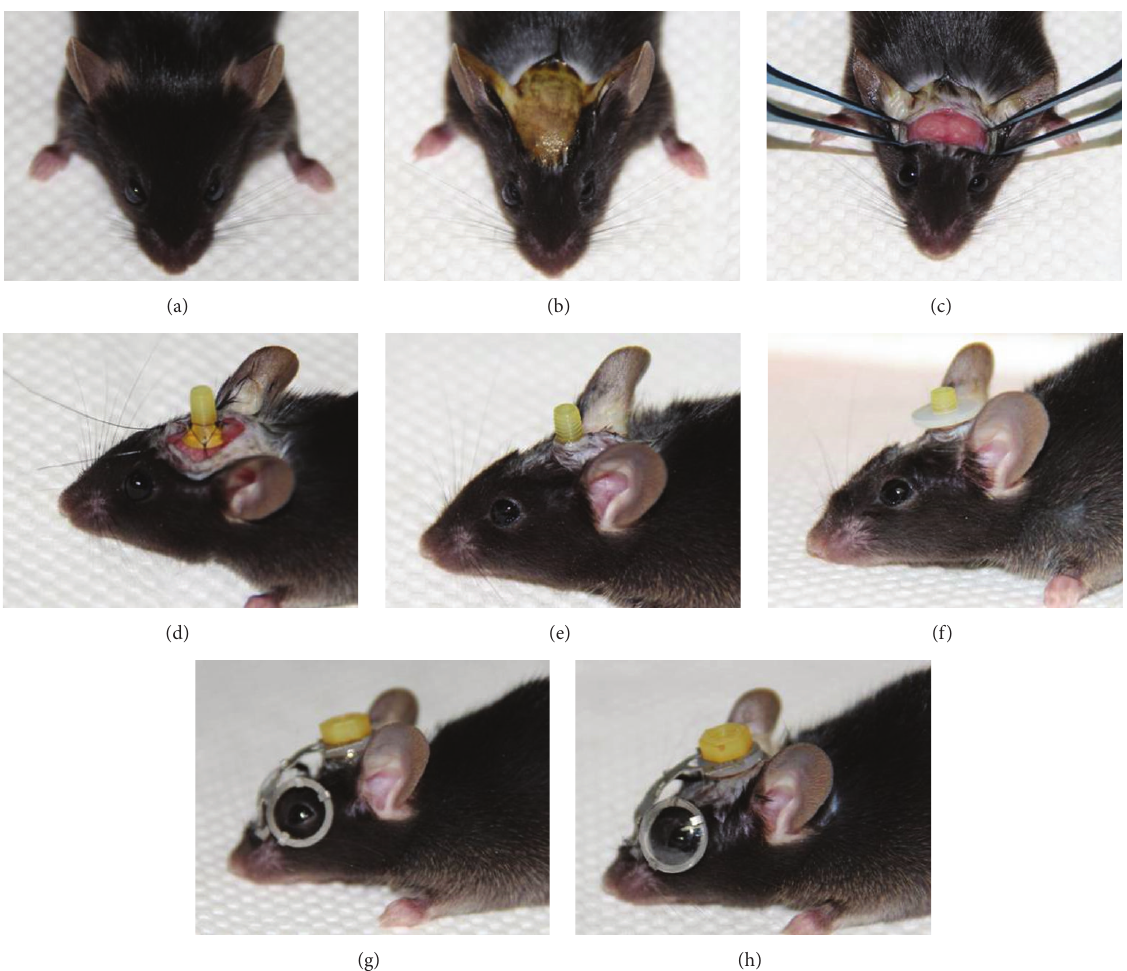
Figure 3: Simplified operation procedures of the head-mounted spectacle frame apparatus: (a) general anesthesia; (b) incision preparation; (c) exposure of the skull and muscle; (d) suturing the screw; (e) suturing the incision; (f) fixing the gasket; (g) fixing the spectacle frame; and (h) fixing the experimental